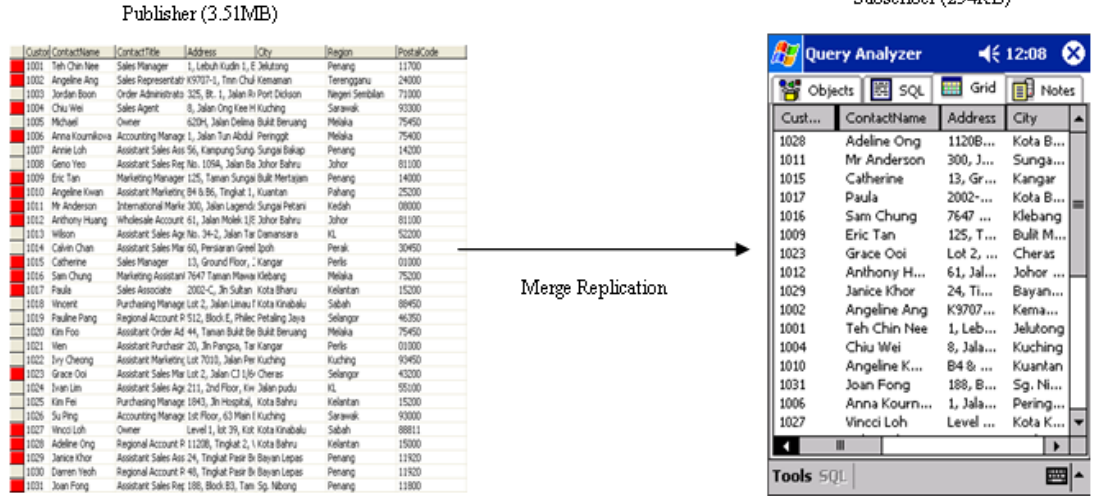
Figure 6: Replication process from subscribers and